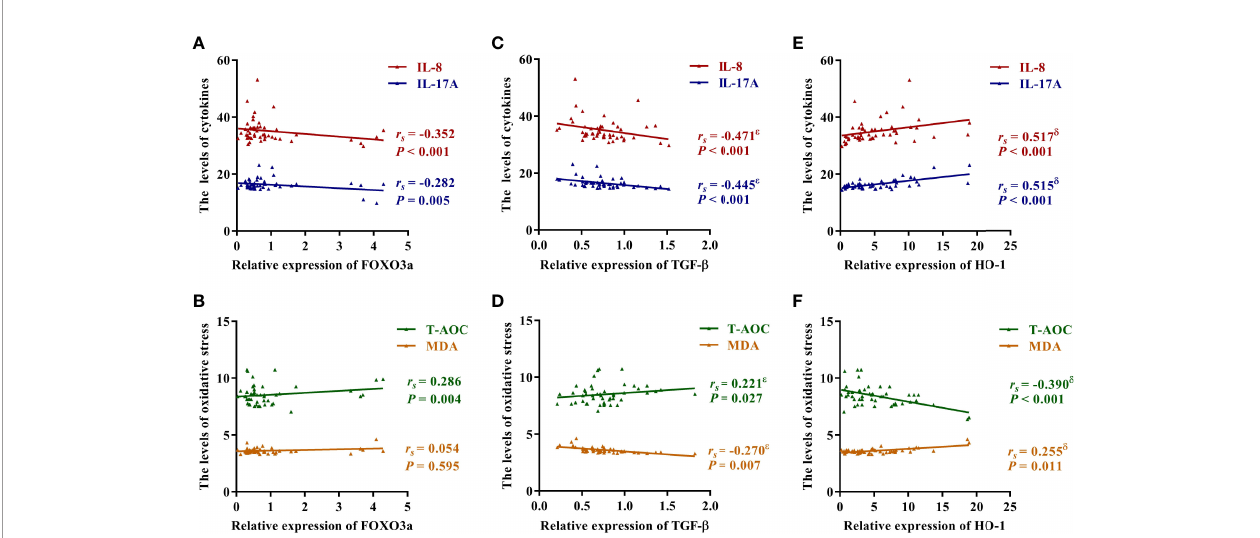
FIGURE 3 | Correlation between FOXO3a, TGF- b , HO-1 and in fl ammation and oxidative stress. (A) Correlation between FOXO3a and IL-8 and IL-17A. (B) Correlation between FOXO3a and T-AOC and MDA. (C) Correlation between TGF- b and IL-8 and IL-17A. (D) Correlation between TGF- b and T-AOC and MDA. (E) Correlation between HO-1 and IL-8 and IL-17A. (F) Correlation between HO-1 and T-AOC and MDA. The correlation was analyzed using spearman rank correlation and partial correlation. r s , Spearman ’ s rank correlation coef fi cient; ϵ , the correlation was still signi fi cant in partial correlation analysis which controlling for HO-1; d , the correlation was still signi fi cant in partial correlation analysis which controlling for TGF- b